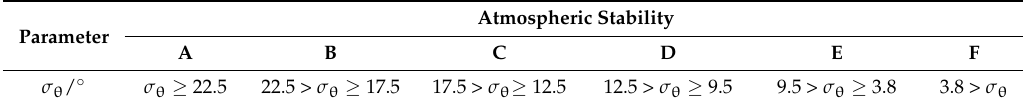
Table 2. Relationship between σ θ and the atmospheric stability.